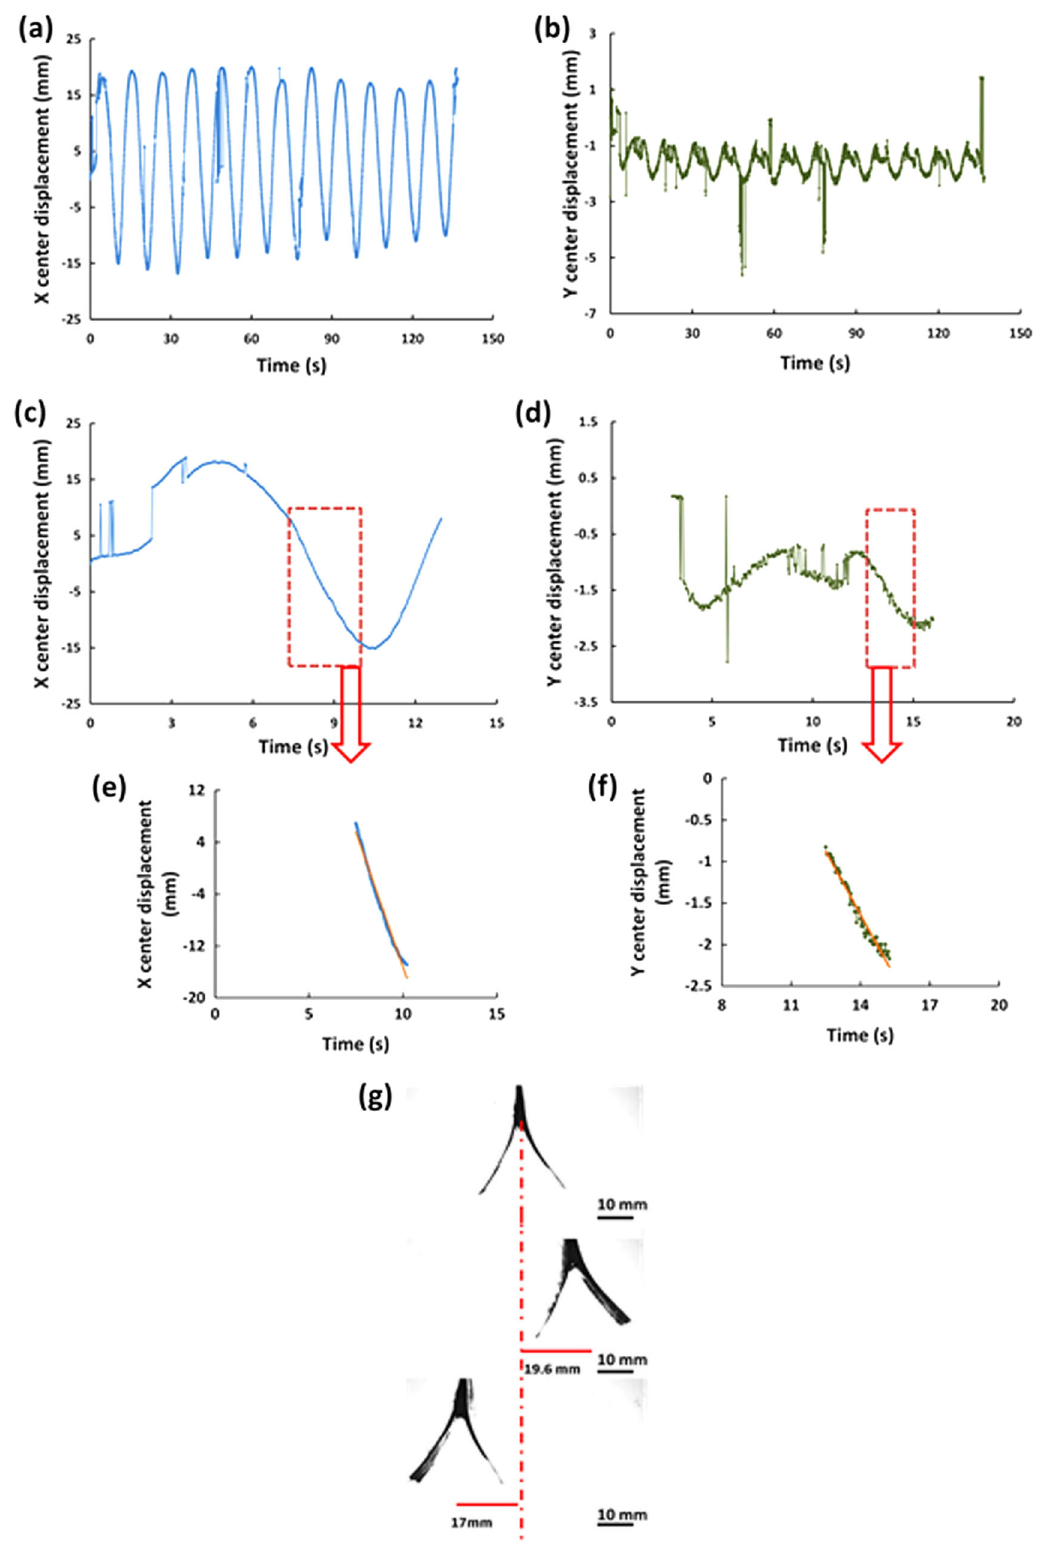
Fig. 5 Swing-like motion of the assembly of two Bare+NT heaters. a The displacement of the center in the X-direction vs. time. b The displacement of the center in the Y-direction vs. time. c The X displacement of the heater assembly for the fi rst 14 s. d The Y displacement of the heater assembly for 4 – 16 s. e An approximately linear section of the dependence X(t), with the blue line being the data and the orange line - the linear approximation, where the velocity | d X /d t | = 0.83 cm/s. f An approximately linear section of the dependence Y(t), with the green line being the data and the orange line -the linear approximation, where the velocity | d Y /d t | = 0.50 cm/s. g Several snapshots of the heater assembly motion at the peak amplitudes being 19.6 mm — for Heater 1and 17 mm — for Heater 2